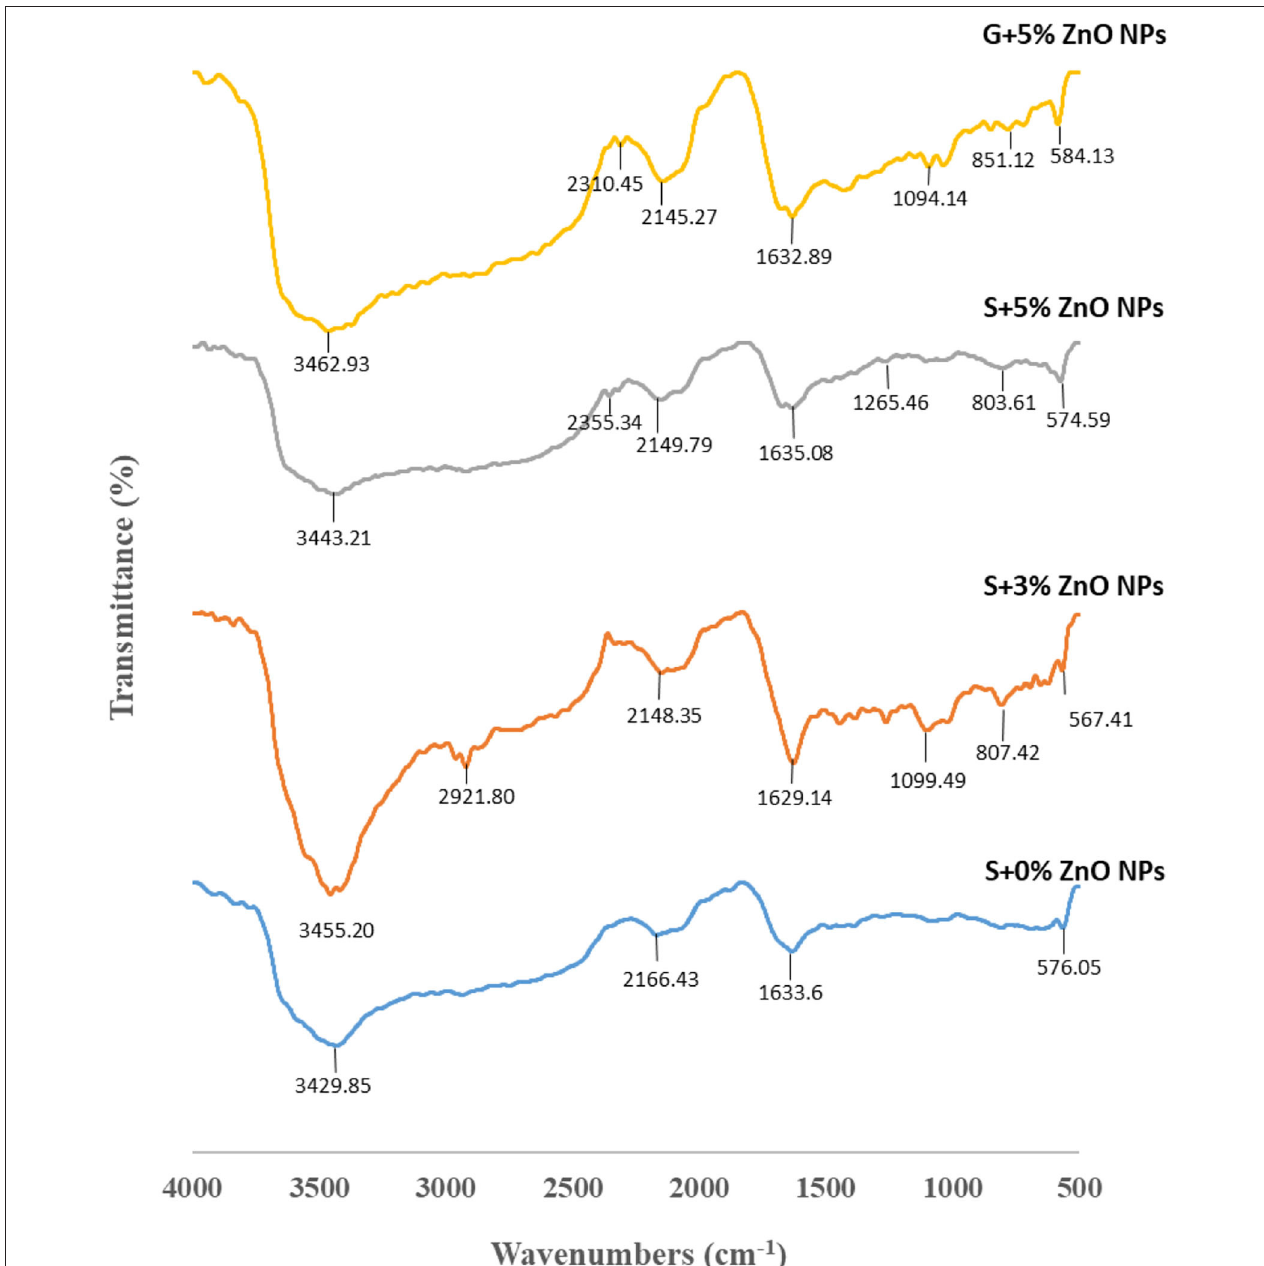
FIGURE 4 | Fourier Transform Infrared (FTIR) spectra of the bionanocomposite